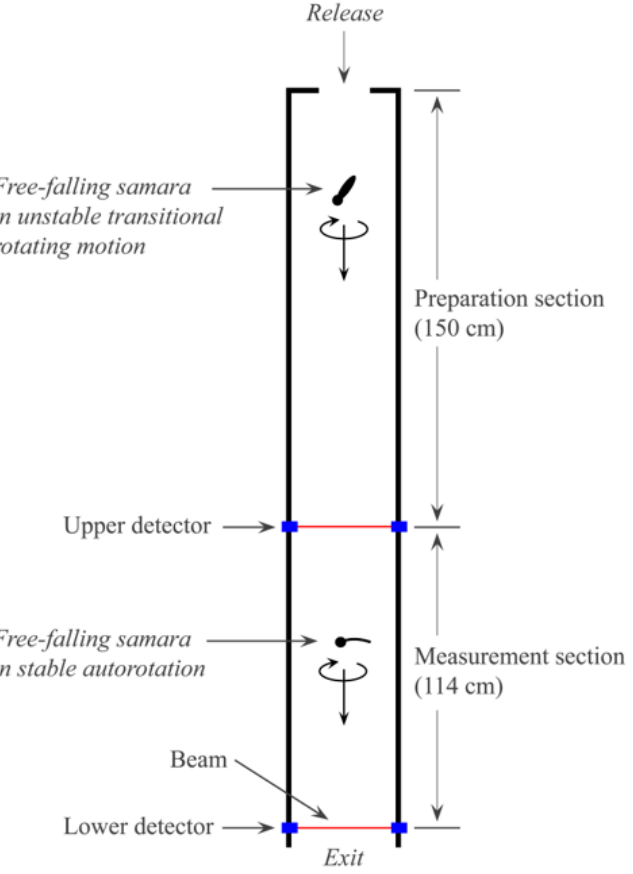
Figure 2. Illustration of the apparatus used for the measurement of terminal velocity of samara in the free-falling test.